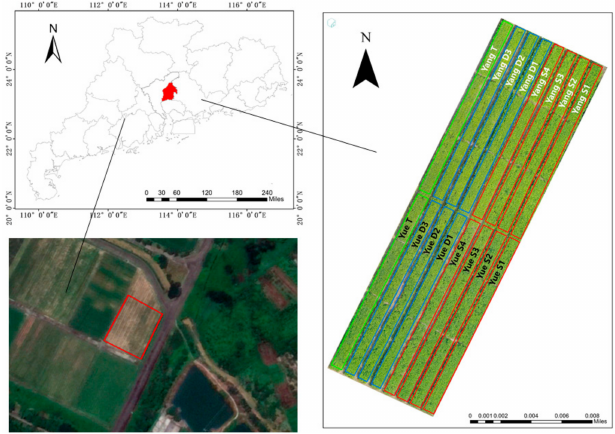
Figure 1. Location of the test area.